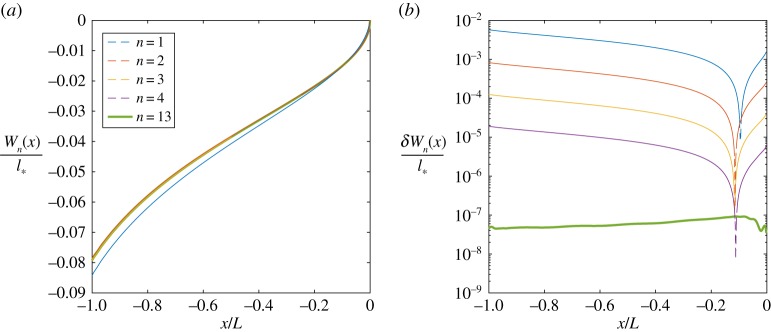
Convergence of Wn(x) for L* = 0.5.